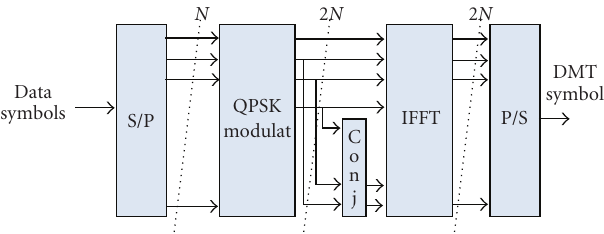
Figure 2: Block diagram of the baseband DMT